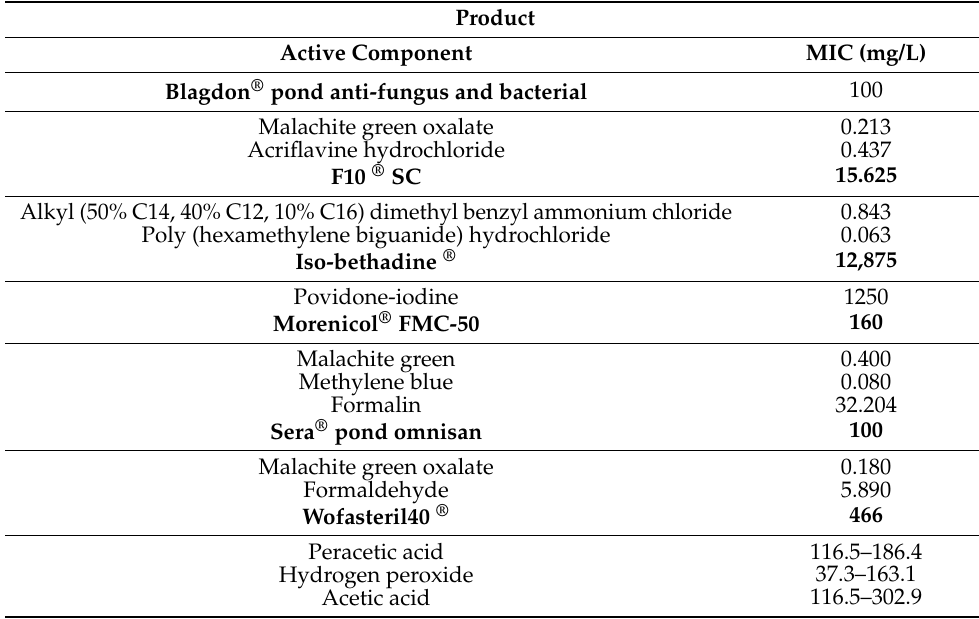
Table 1. MIC-values (mg/L) of commercial products and their active components against Bd.